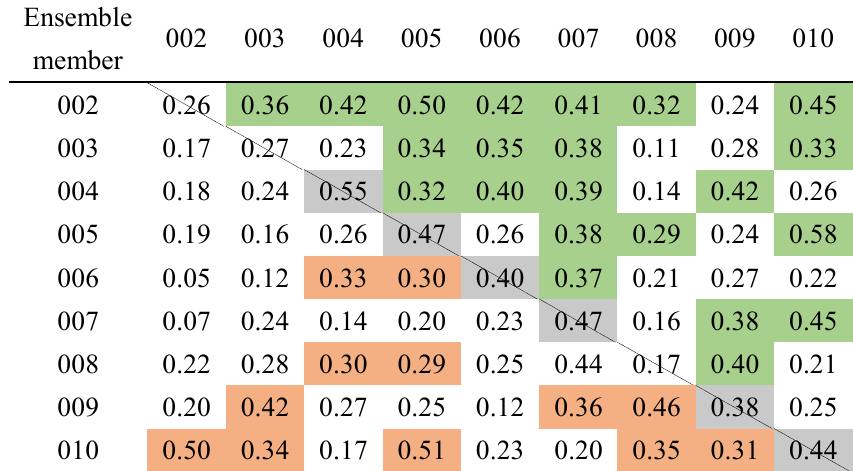
Table 2. Pairwise correlation coefficients between the 31-year running averaged summer SSTs over the North Atlantic (NASST) among CESM-LME full-forcing experiments (upper right portion). The lower left portion is the same but for the SSTs over the North Pacific (NPSST). The numbers along the diagonal are the correlation coefficients between the NASST and NPSST in individual members. The North Atlantic and North Pacific regions are selected for 30–70 ◦ N, 80 ◦ W–0 ◦ and 30–65 ◦ N, 160 ◦ E–140 ◦ W, respectively. Colored grids represent the values that passed the 95% significance